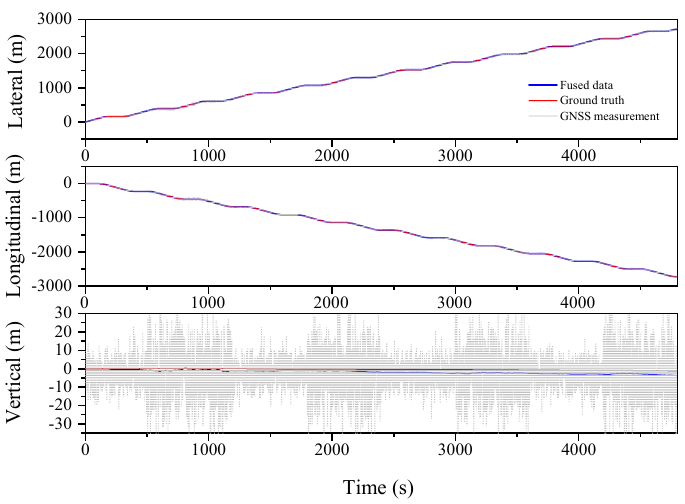
Figure 12. Lateral, Longitudinal and Vertical positions of ESKF − RTS (Serpentine 2).